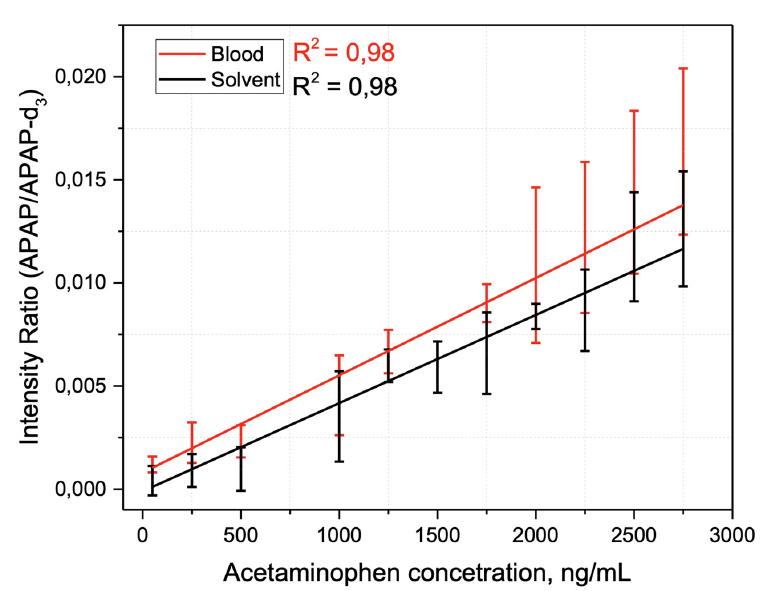
Figure 9. Calibration curves in positive mode ( p -value < 0.05): black: acetaminophen with APAP- d 3 as an internal standard. Matrix: 9:1 ( v : v ) MeOH:H 2 O; R 2 = 0.98. red: papaverine with caffeine-trimethyl- 13 C 3 as an internal standard. Matrix: dried blood; R 2 = 0.98.